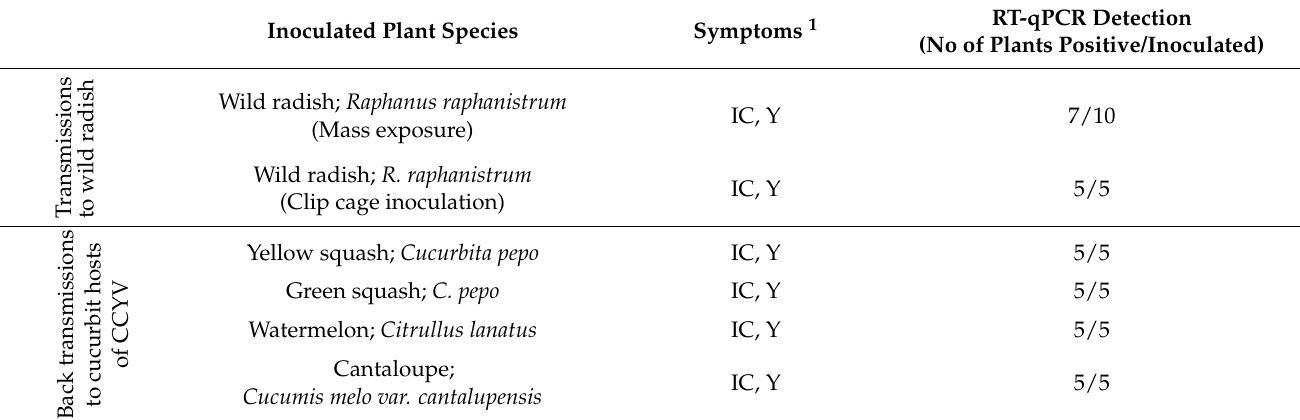
Table 2. Infection of wild radish with cucurbit chlorotic yellows virus (CCYV) and back transmis- sion to cucurbit hosts. Wild radish infected with CCYV were used as source plants for back trans- missions to cucurbit hosts. Virus infections on inoculated plants were determined by RT-qPCR 3 weeks after inoculation.